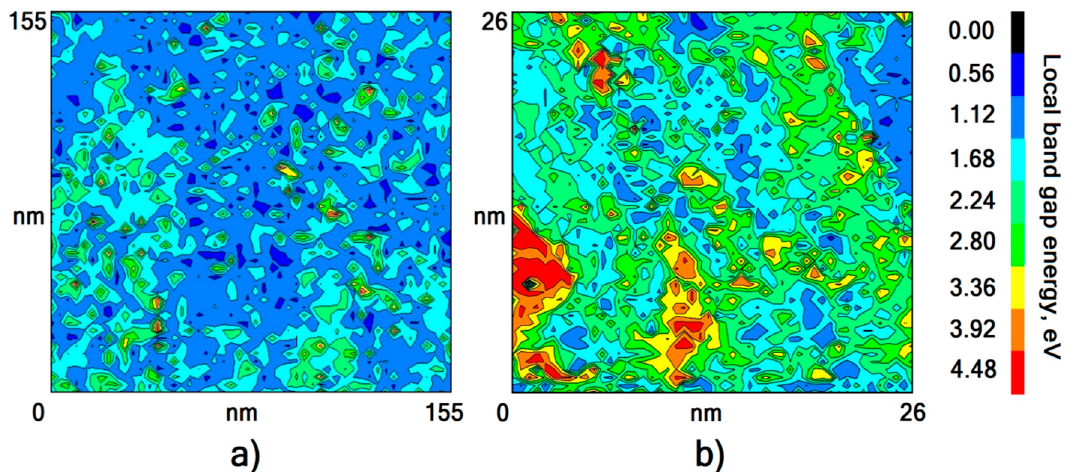
Figure 3. Map of the oxide phase distribution over the titanium coating surface. Different colors indicate areas with different local band gap values E gloc : ( a ), oxidation in air ( t = 720 h, T = 300 K); ( b ) oxidation during annealing ( t = 13 h, T = 770 K).